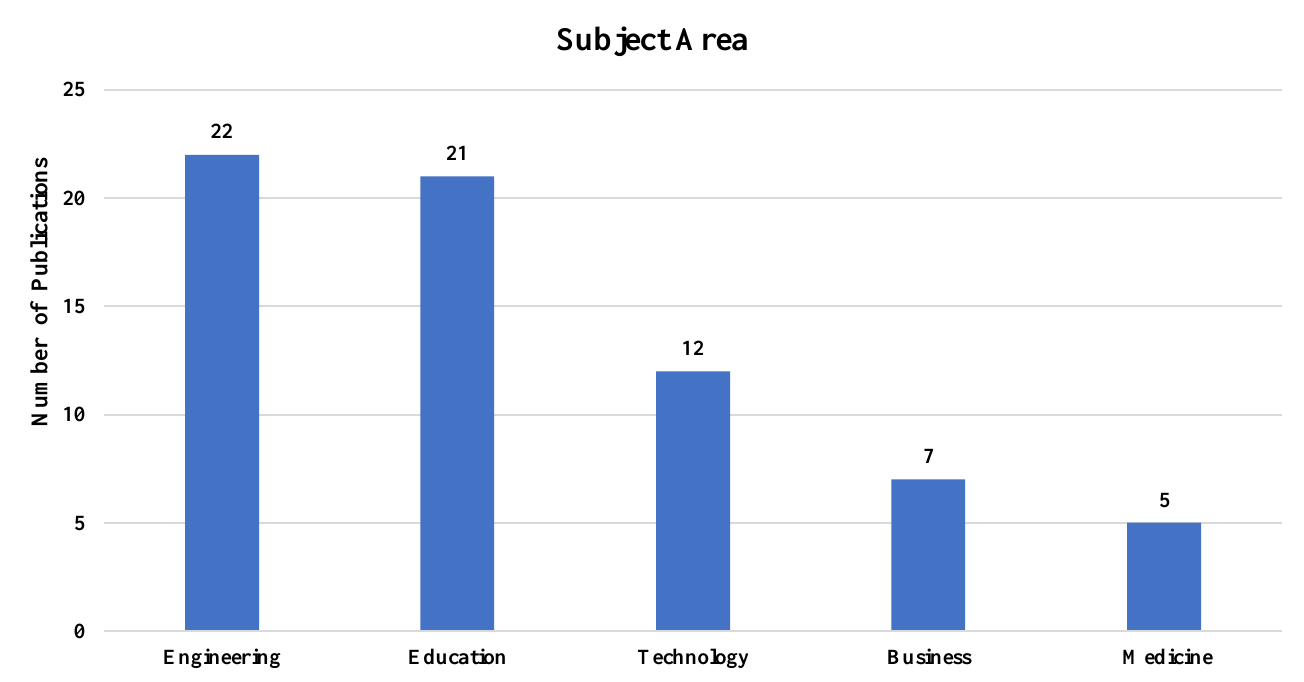
Figure 5. Top five subject areas of the retracted publications from